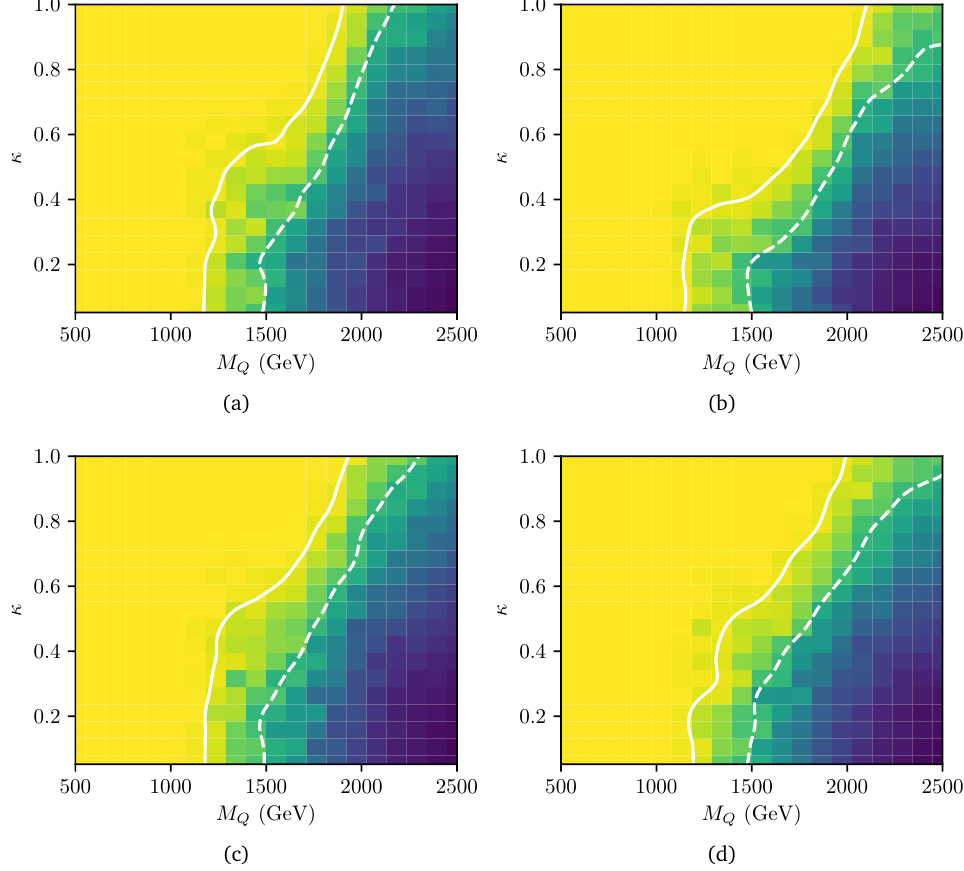
Figure 22: Sensitivity of LHC measurements to VLQ production in the κ vs VLQ mass plane, where κ is the coupling to third-generation SM quarks. All VLQ ( B , T , X , Y ) masses are set to be degenerate. The green to yellow regions are disfavoured at 68% CL to 95% CL respectively, with the dashed and solid white contours delineating the boundaries. The VLQ branching fractions to W : Z : H are (a) 0:0:1 (b) 0:1:0 (c) 1:0:0 and (d) 1 : 1 : 1 2 4 4